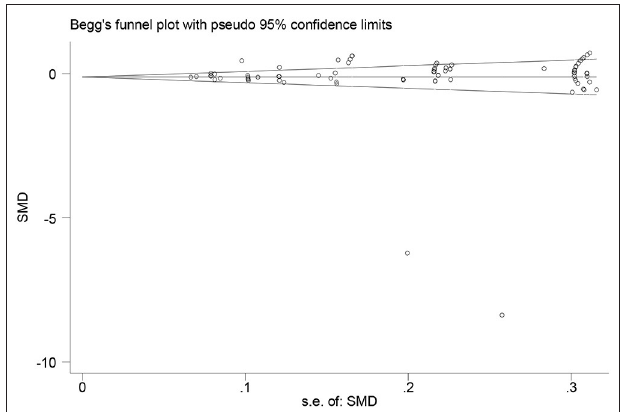
FIGURE 2 | A funnel plot of publication bias using Begg’s